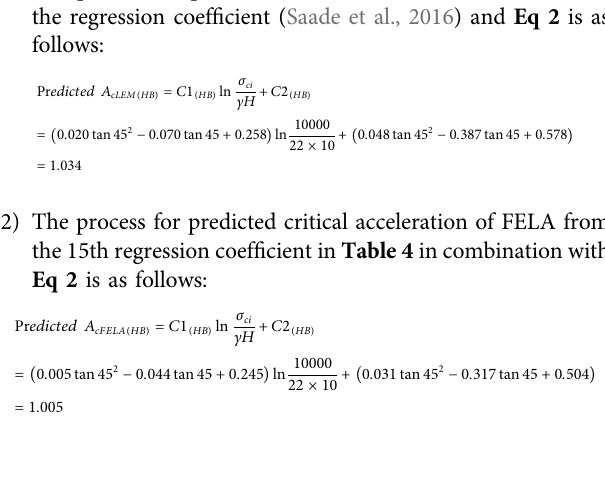
FIGURE 8 | Comparison between the A c values predicted and calculated with FELA for m i = 25, σ ci = 5 and 25 MPa, 45 ° ≤ β ≤ 80 ° and GSI = 20,30,40and50whenusingtheHBfailurecriterion. (A) GSI =20and30and σ σ ci = 5 MPa; (B) GSI = 40 and 50 and ci = 5 MPa; (C) GSI = 20 and 30 and σ ci = 25 MPa; and (D) GSI = 40 and 50 and σ ci = 25 MPa.